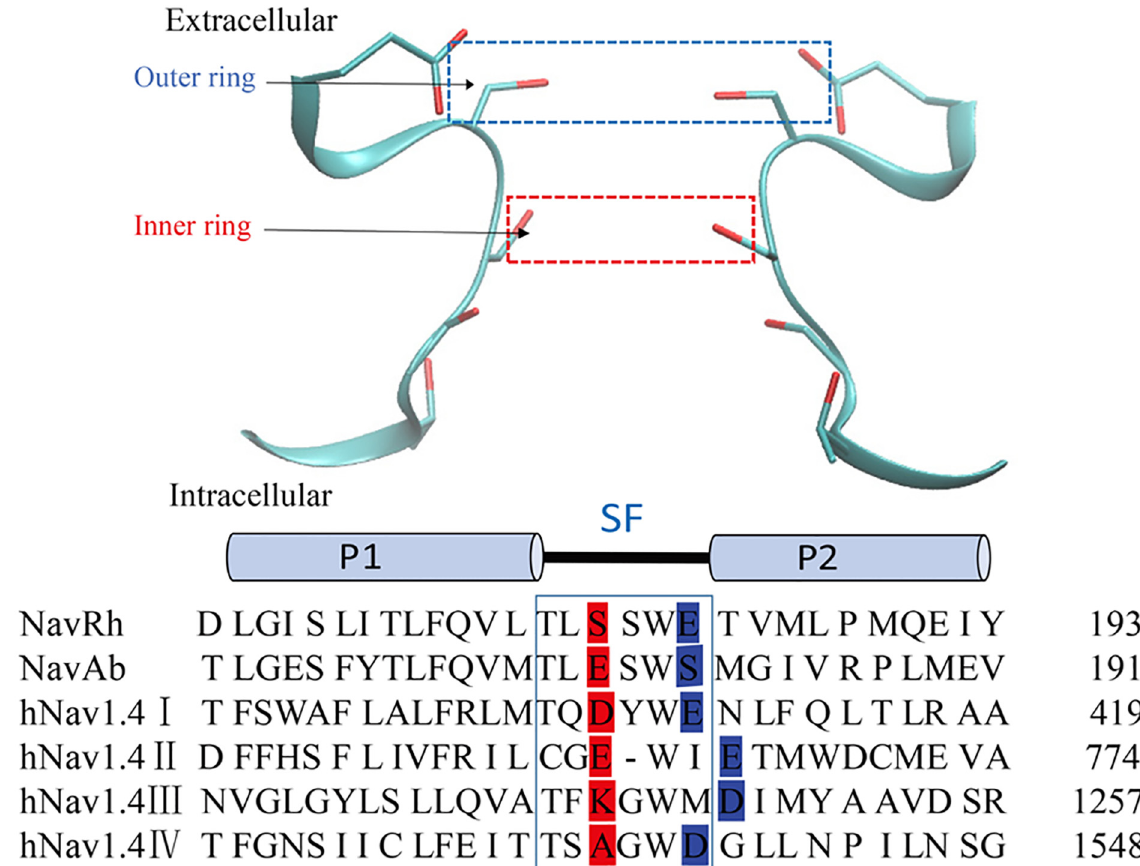
Fig 1. The structural representation and sequence alignment for the SFs of Na v channels. In the structural representation (upper panel), the Na v Rh crystal structure is shown as an example, where only two of the four chains (A and C) are represented in cartoons for clarity. In the sequence alignment (lower panel), the sequences for two prokaryotic channels (Na v Rh and Na v Ab) as well as the four domains of one mammalian channel (human Na v 1.4) are compared side-by-side, with the P-loop of the SF region highlighted by a blue frame. Two rings of residues are highly conserved in mammalian Na v channels: the inner ring (shaded in red) and the outer ring (shaded in blue). The positions of these two rings are labeled by dotted frames colored in red and blue respectively, in the structural representation (upper